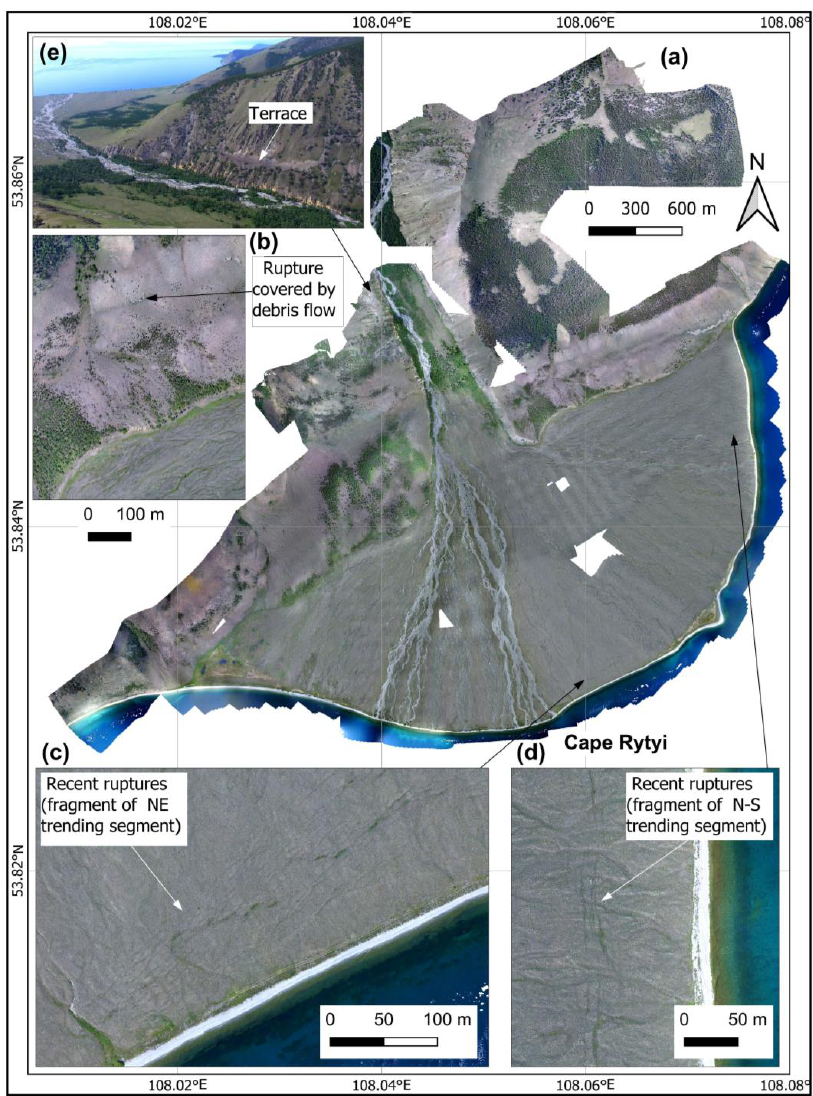
Figure 3. ( a ) Orthophotomap of Cape Rytyi; ( b – d ) its fragments; ( e ) location of the Rita River terrace of ~39 m in height according to the aerial photography data from the summer of 2019.